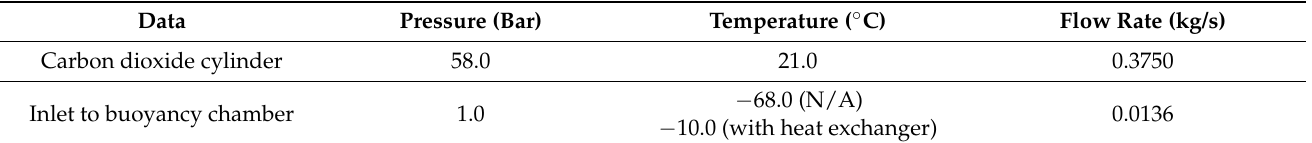
Table 7. Pressure and temperature simulation result for the buoyancy chamber inflation.